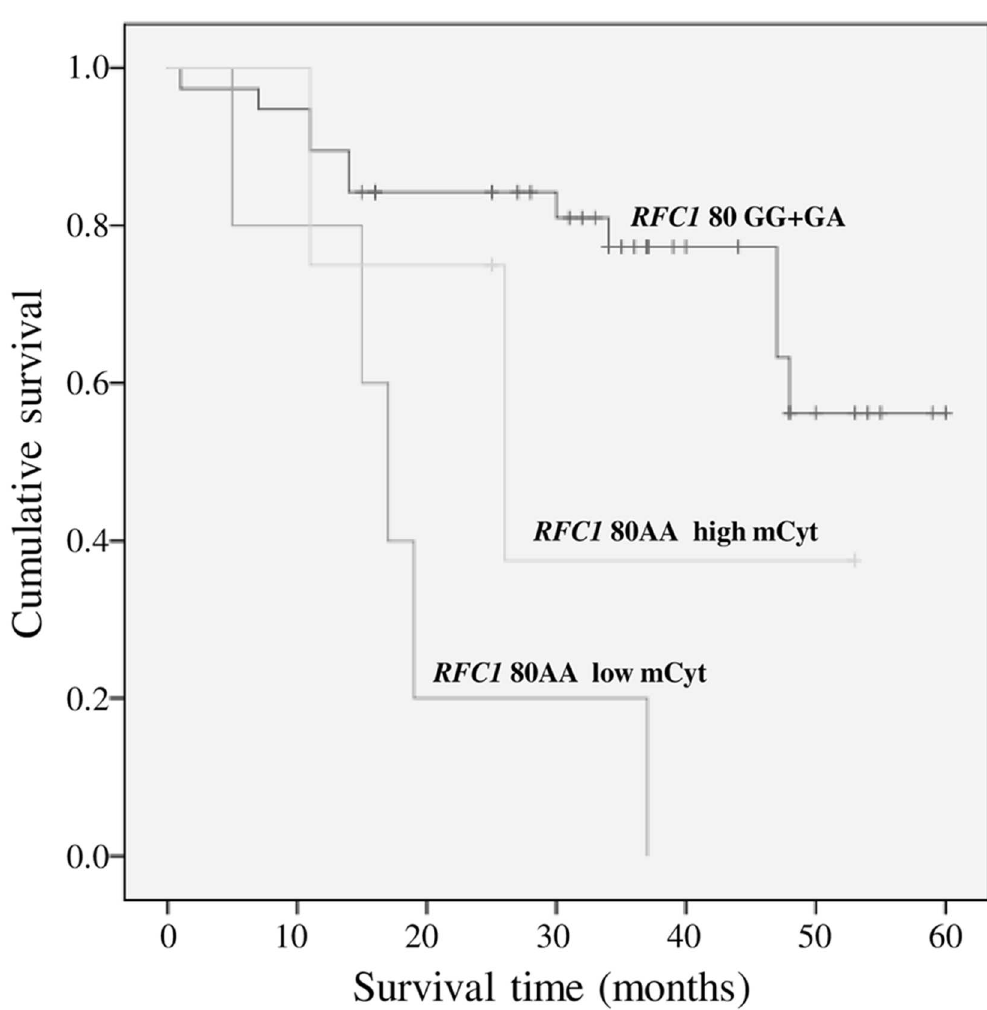
Fig 2. Survival curves plotted by Kaplan-Meier analysis according to RFC1 80G > A genotypes and mCyt levels. RFC1 80AA patients with low mCyt levels ( (cid:20) 5.34%)were associated to a lower survival as comparedto carriers of the RFC1 80G allele(71.1%) (p < 0.0001). The comparisonbetween RFC1 80G carriers and RFC1 80AA with high mCyt ( > 5.34%)was not statistically significant(p = 0.919), as it was the comparisonbetween RFC1 80AA with low mCyt and with high mCyt (p =